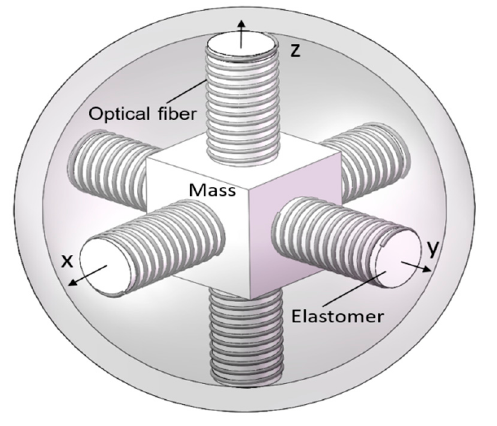
Figure 1. The composition of the accelerometer.